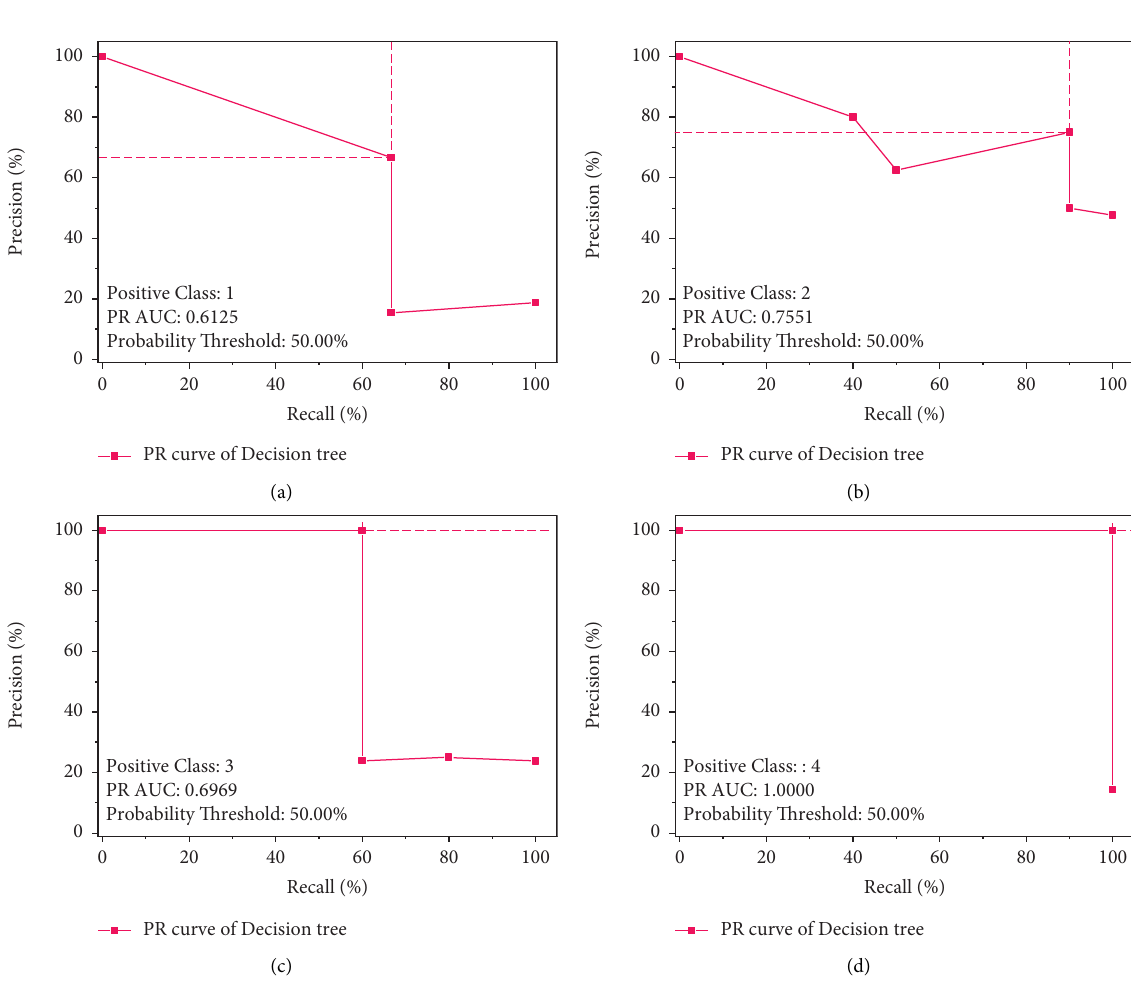
Figure 11: PR curve of each classification test of the decision tree